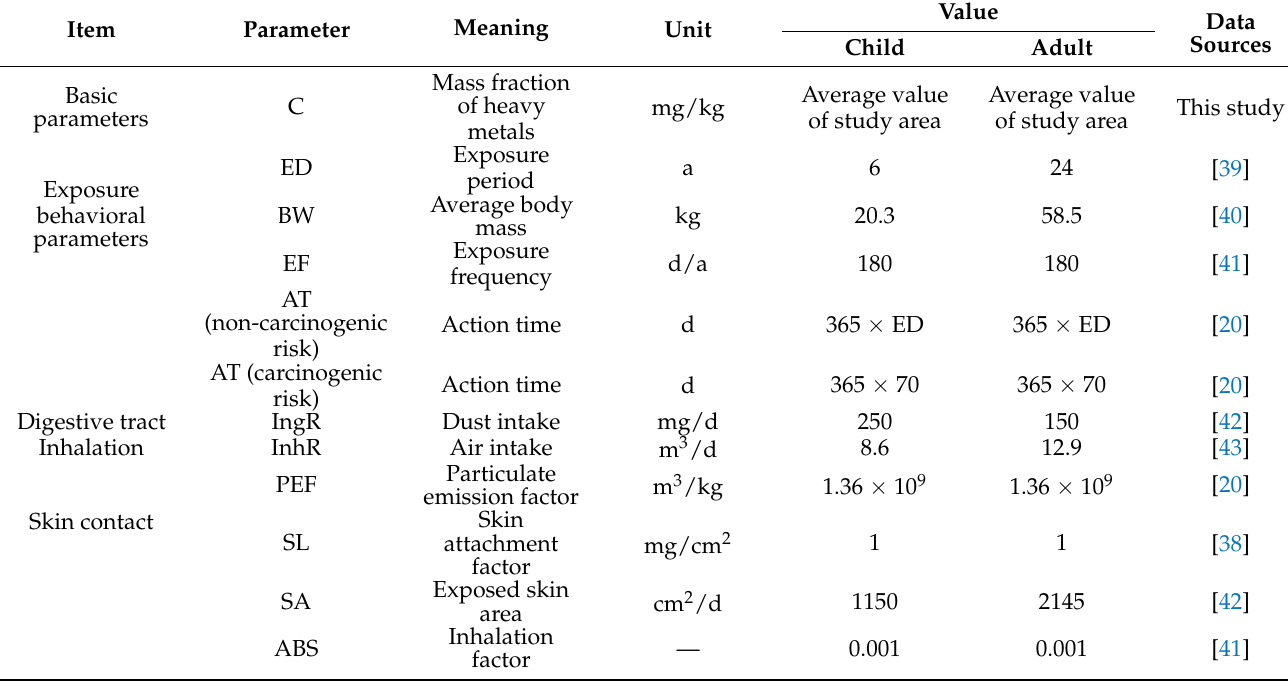
Table 2. Calculation parameters of daily average dust